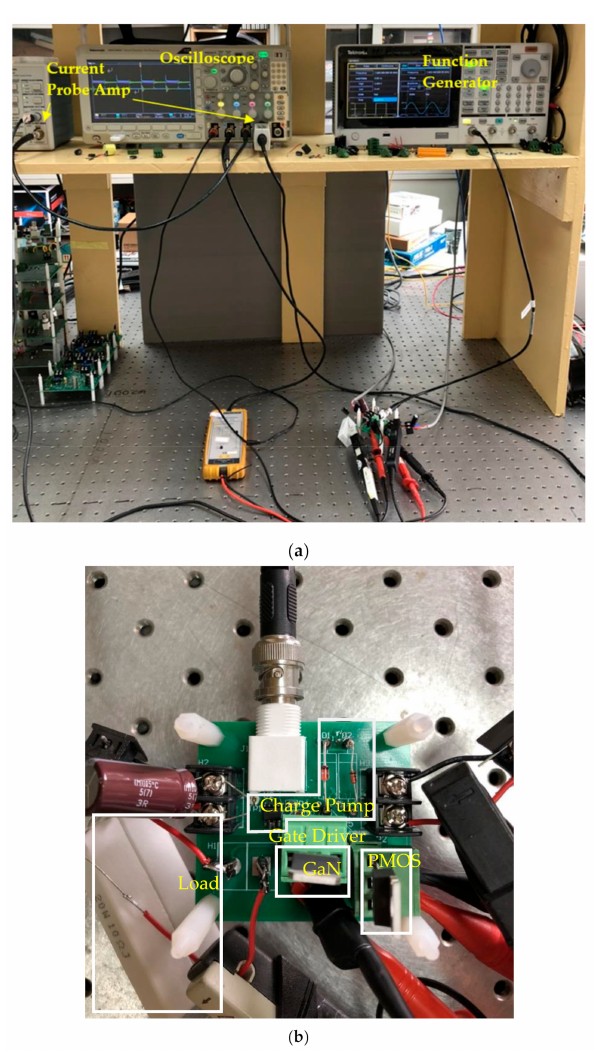
Figure 22. ( a ) Experimental setup and ( b ) photo of the circuit in the